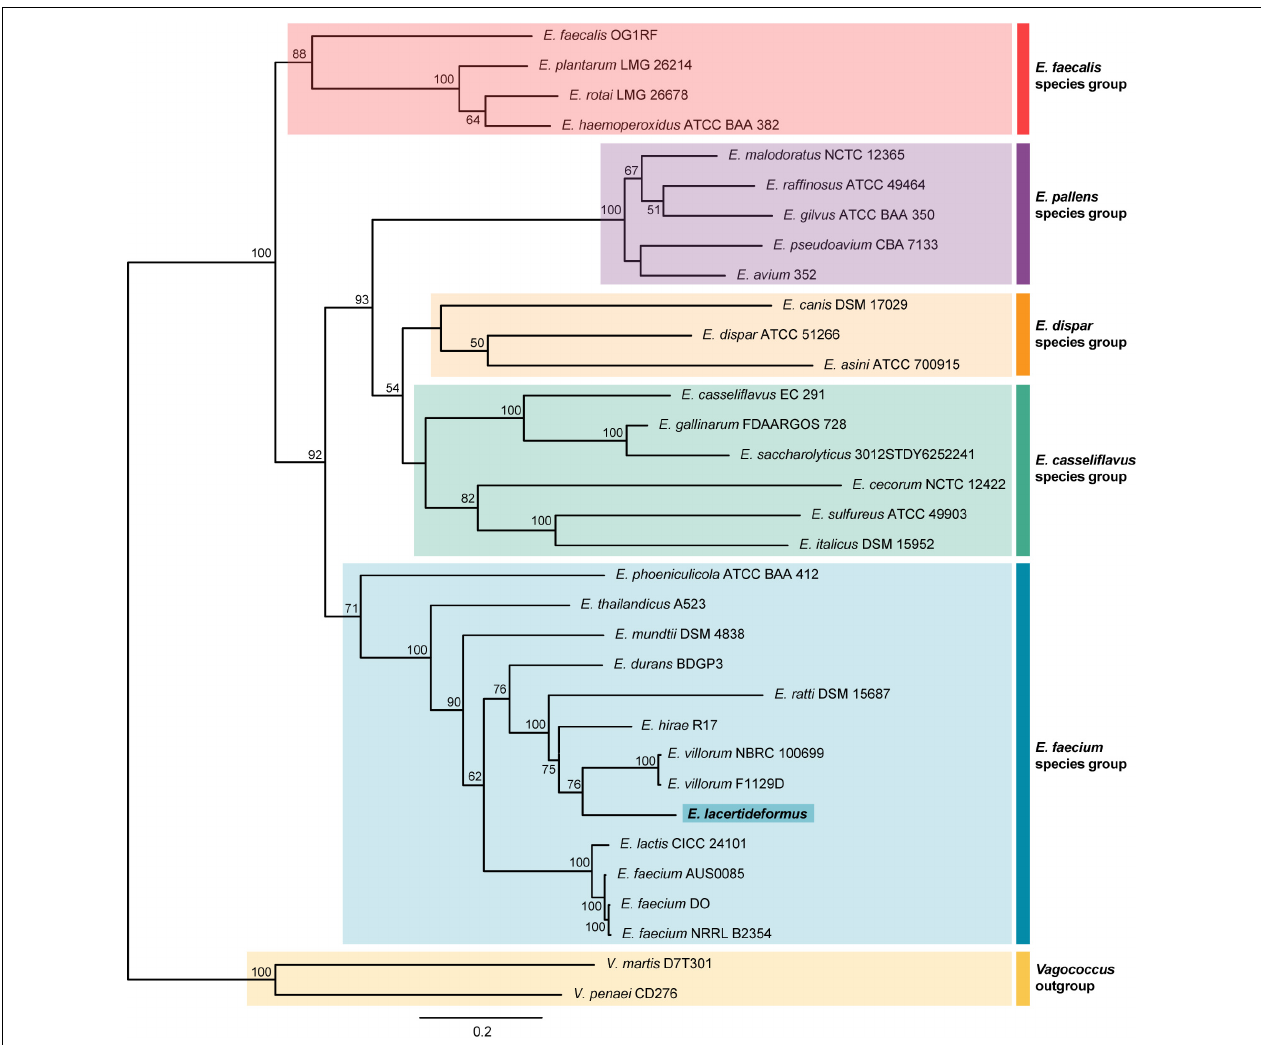
FIGURE 2 | Multi-locus phylogenetic tree. The evolutionary history using seven enterococcal house-keeping genes (atpA, adk, ddl, gdh, gyd, pstS, and purK) was inferred by the Maximum Likelihood method, employing the General-Time-Reversible model with Gamma distributed plus Invariant sites (GTR + G + I), with 33 nucleotide sequences including the novel E. lacertideformus . The percentage of trees in which the associated taxa clustered together is shown next to the branches and is derived from 1,000 bootstraps (bootstraps > 50% shown). There was a total of 3,461 positions in the final dataset. The various enterococcus clades are shaded, with the E. faecium species group highlighted in blue, and novel E. lacertideformus denoted in bold (dark blue